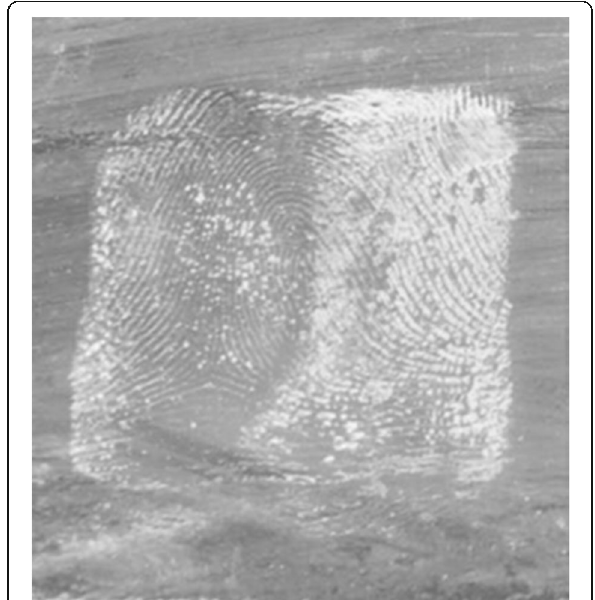
The brush used: 120LS Squirrel Hair brush with dimensions; Handle length: 4 5/8 ” (11.75 cm), Brush Length: 1 3/4 ” (4.45 cm). –